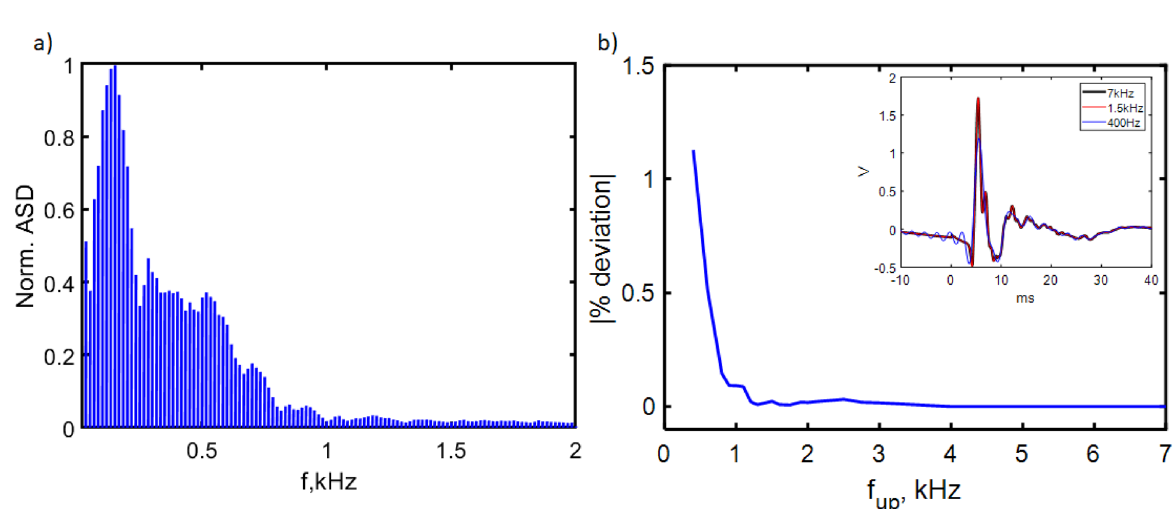
Figure 4. Frequency spectrum of the biological signal and defining optimum filter thresholding. ( a ) Spectrogram of the normalised Fourier transform amplitudes of the electrical probe voltage data, showing that the majority of the signal frequency components (shaded blue region) are under 1.5 kHz. ( b ) Percentage deviation from the unfiltered signal as a function of upper bandpass cutoff frequency f up . The signal begins to be significantly corrupted below 1.5 kHz, as can be seen in the inset example for f up stimulation